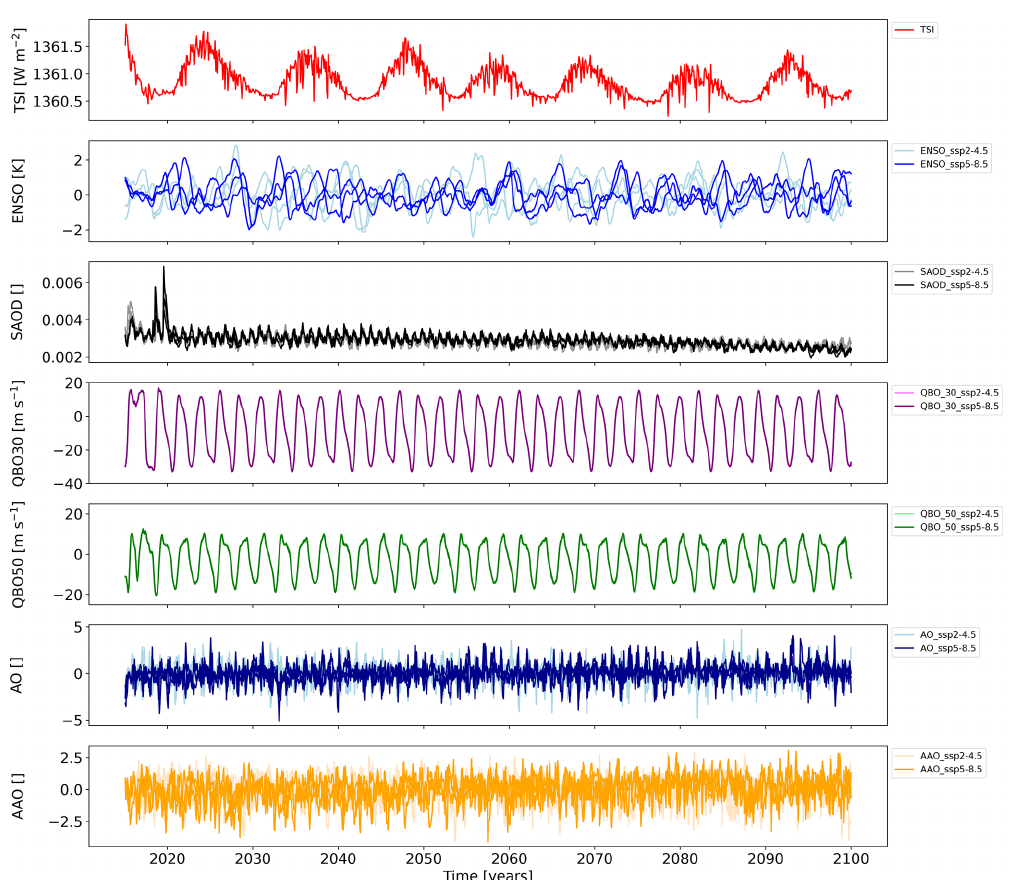
Figure A1. Input quantities (proxy variables) for the forcing of the SOCOLv4 simulations. Faded colors are for SSP2-4.5; bright colors are for SSP